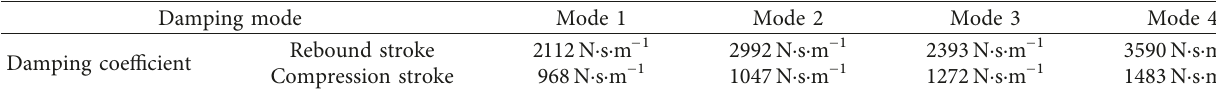
Table 2: Damping coefficients in different damping modes.